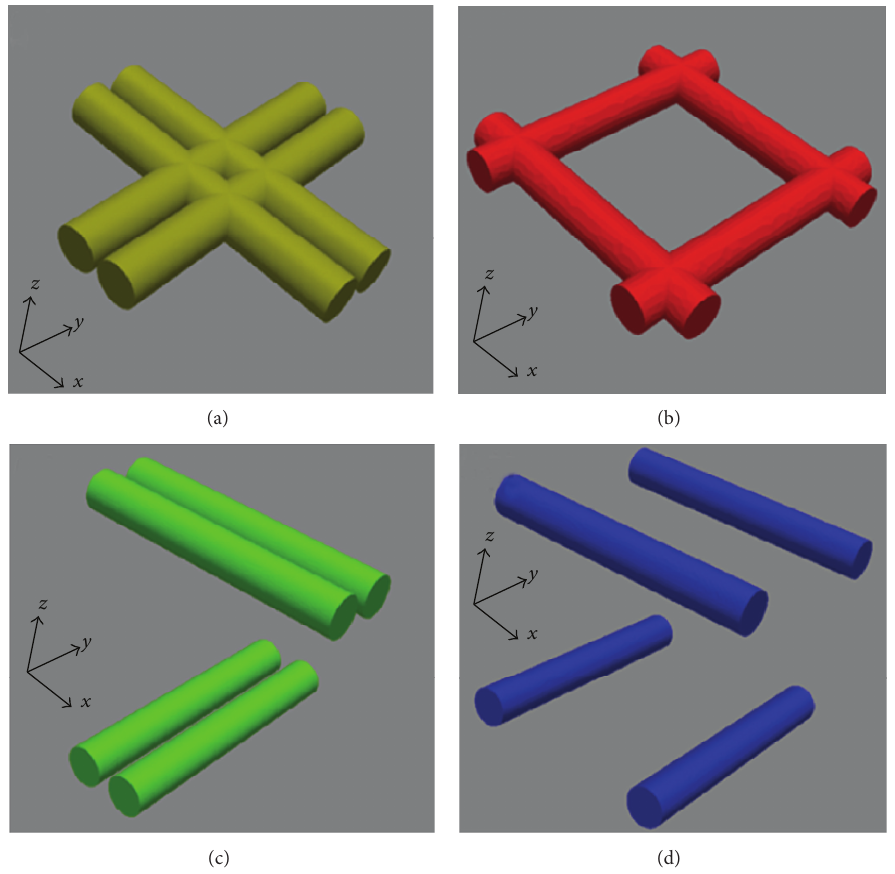
Figure 1: Magnetic systems composed of four nanowires, arranged in perpendicular pairs, with a different coupling within one pair/between the pairs: maximum coupling between the pairs and (a) coupling/(b) no coupling within each pair; no coupling between the pairs and (c) coupling/(d) no coupling within each